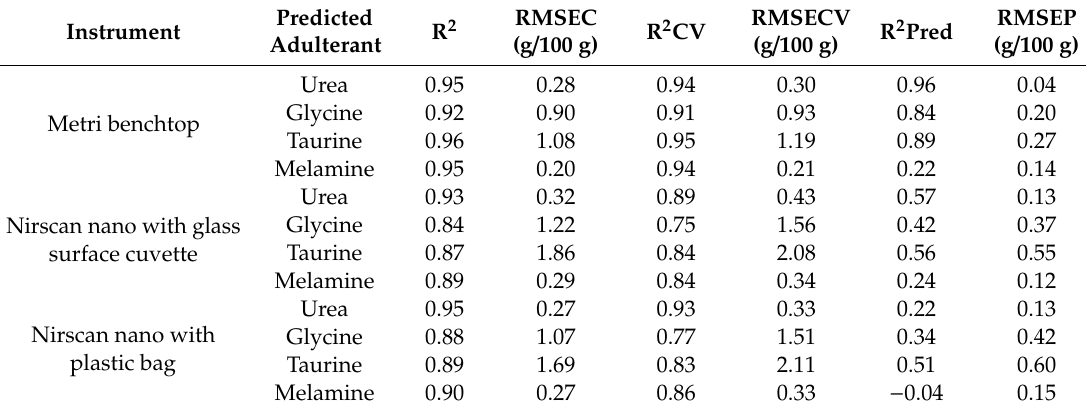
Table 4. PLSR models developed with the benchtop and handheld spectrometers for whey